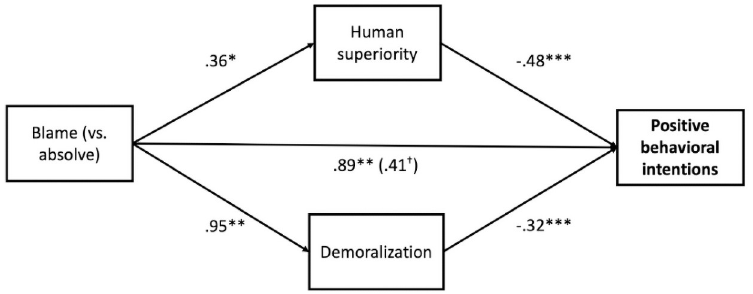
Fig 2. Model testing the effect of condition (blame vs. absolve) on positive behavioral intentions towards veg � nism through human superiority beliefs and demoralization for Study 1. Note . Unstandardized coefficients displayed. � p < .05, �� p < .01, ��� , p < .001, two-tailed